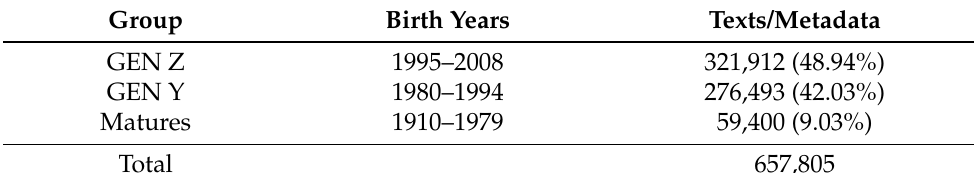
Table 3. Different age cohort descriptors (reduced Strauss and Howe).